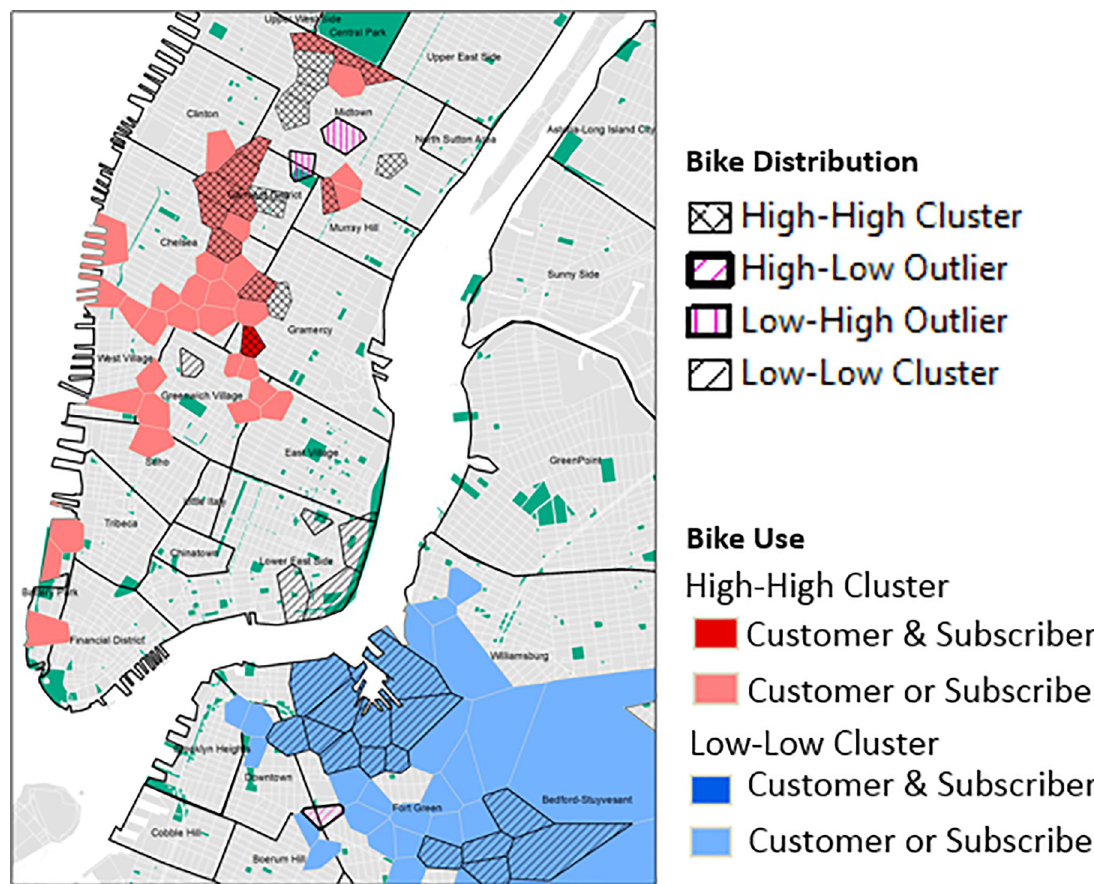
Fig 7. Overlap of statistically significant clusters of the number of bikes with bike usage. (Data Sources: NYC Parks, Census Blocks, NYC Neighborhood Names (S2 Table)).